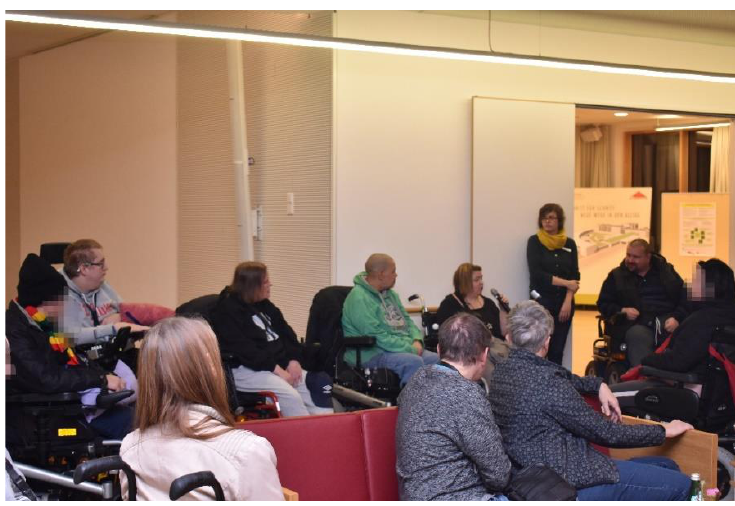
Figure 11. Exhibition opening.